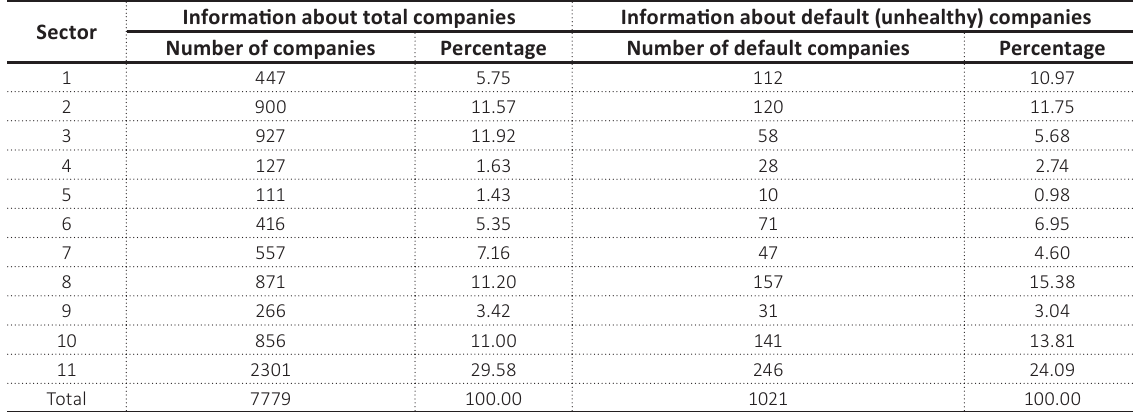
Table 1. Sector-wise data of Czech companies